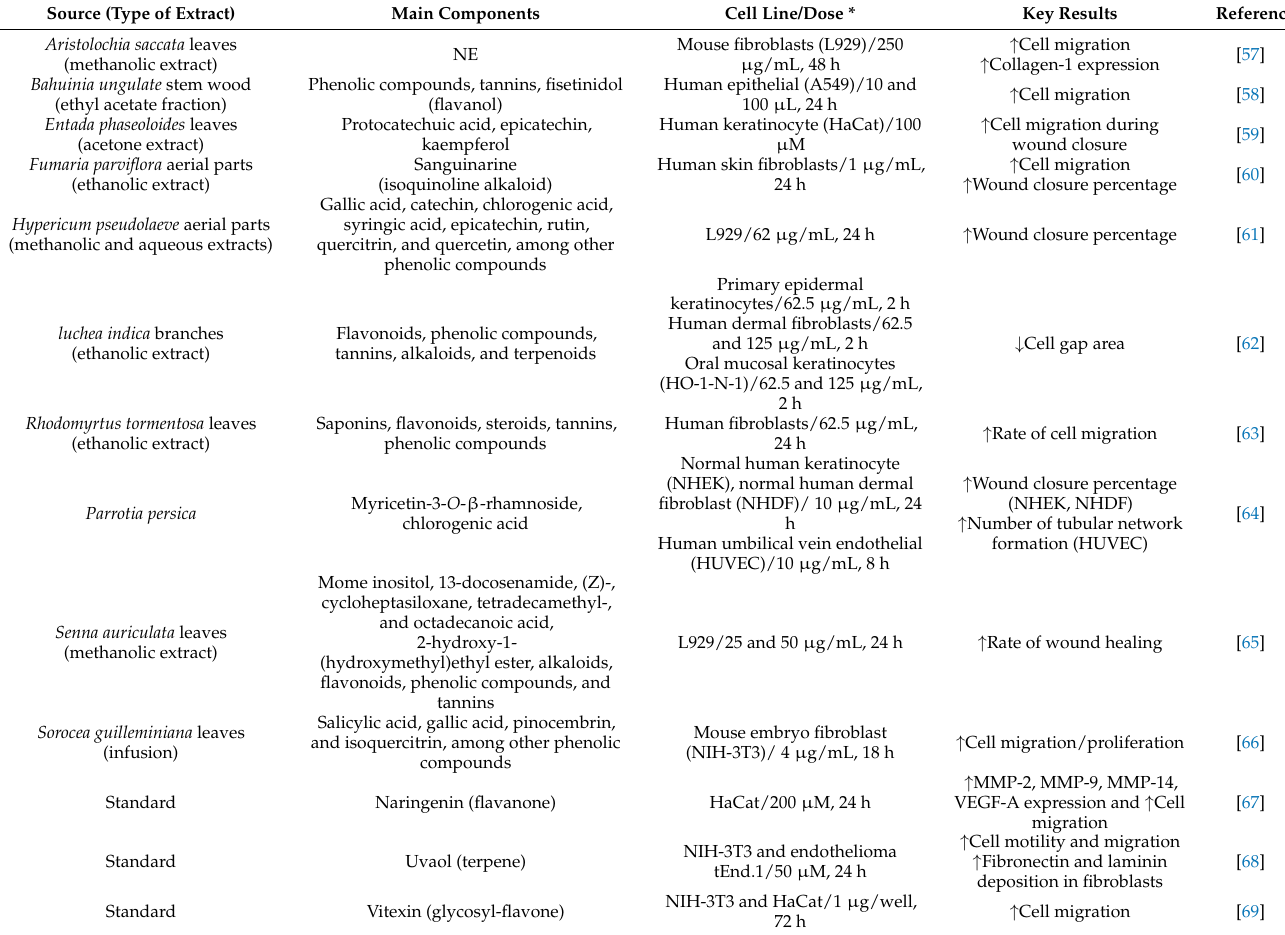
Table 1. In vitro studies evaluating the wound healing potential of natural products.